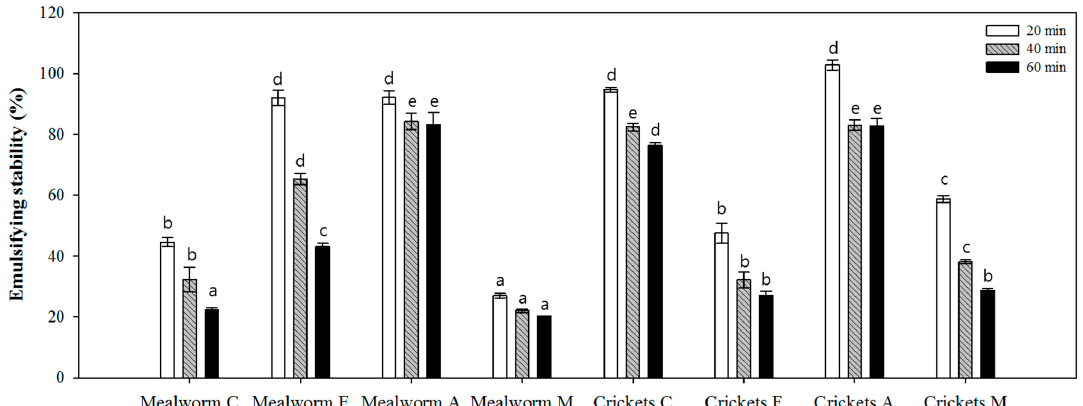
Figure 5. The emulsifying stability index (ESI) of insect proteins and their hydrolysates after 20, 40, and 60 min of emulsion formation. Results are reported as % ESI. Each value is expressed as the mean ± SD ( n = 3); values marked with different letters indicate significant differences among treated groups ( p < 0.05). C, control; F, Flavourzyme; A, Alcalase; M, Flavourzyme + Alcalase.